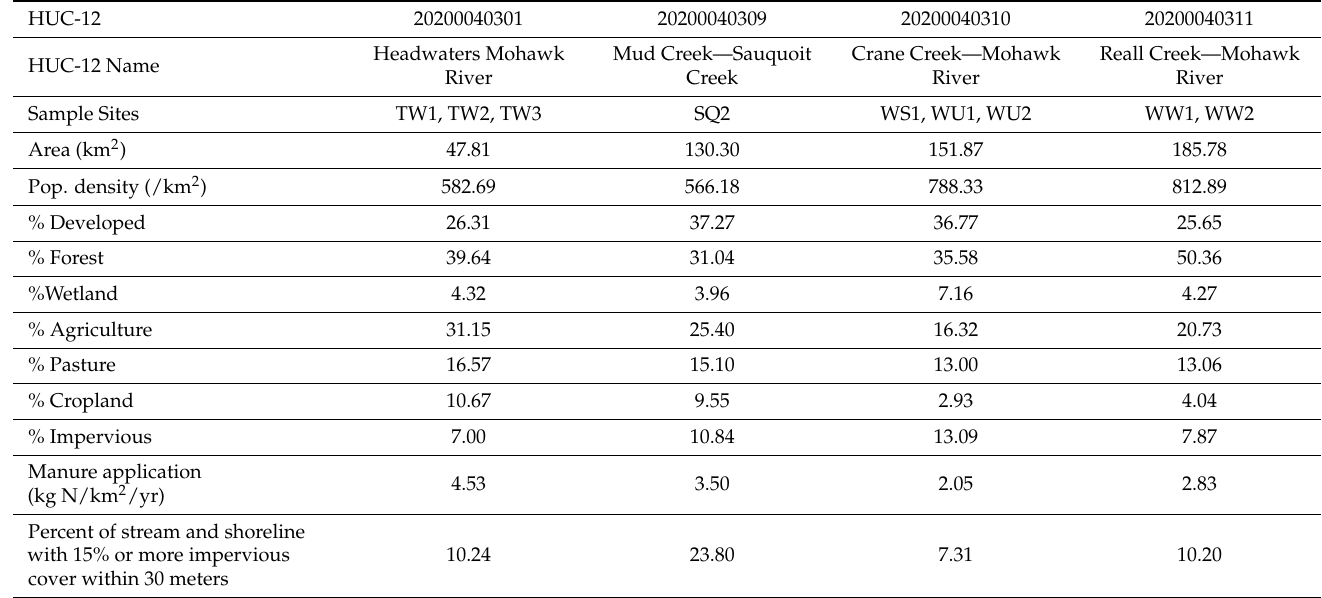
Table 1. Land use and population statistics for HUC-12